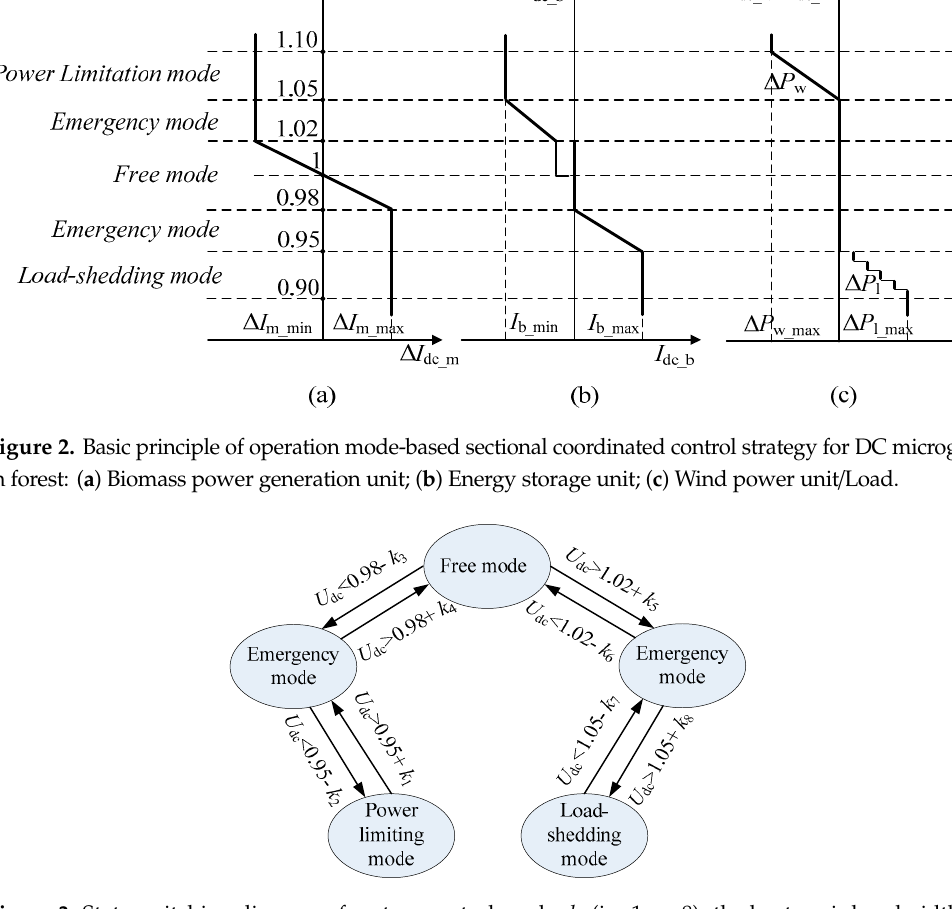
Figure 3. State switching diagram of system control mode. k i (i = 1…8): the hysteresis bandwidth in different modes.